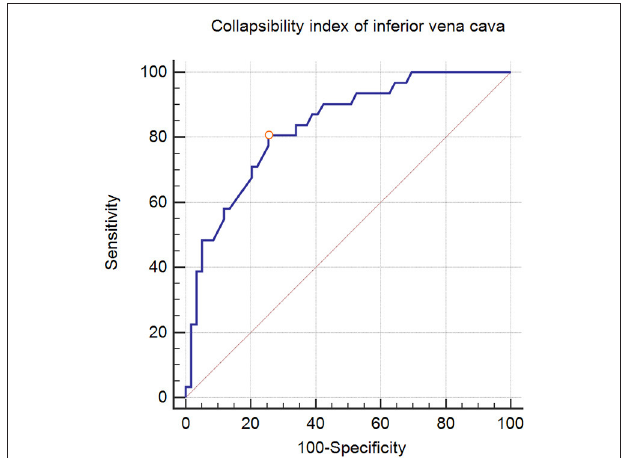
FIGURE 2 | Receiver operating characteristic curves showing the ability of collapsibility index of inferior vena cava to predict hypotension following spinal anesthesia. The circle on the curves indicate the optimal cut-off values determined by maximizing the Youden index.